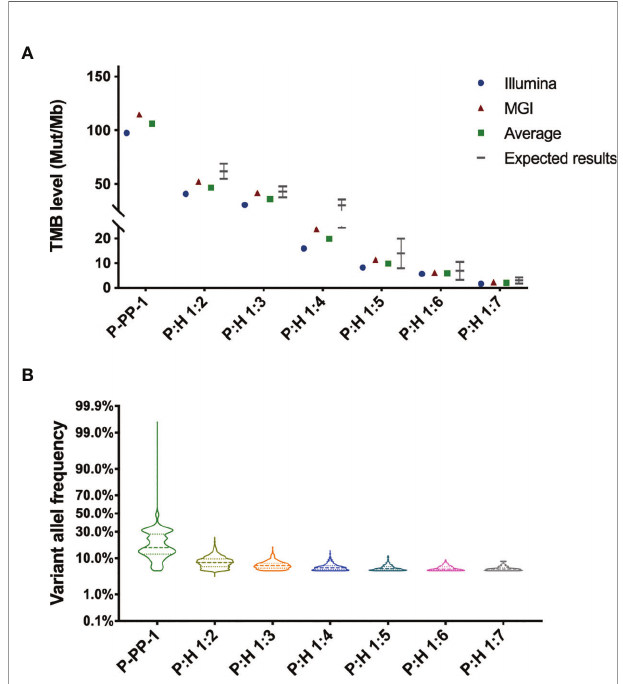
FIGURE 5 | Sample validation of the novel FFPE reference materials by double-platform whole exome sequencing. (A) Sample validation by double- platform whole exome sequencing for the novel FFPE reference materials. Data showed in the form of mut/Mb. The mean values of all samples were consistent with their individual target values, spanning a clinically relevant range (2.0 – 106.1 mut/Mb). (B) Distribution of the variant allele frequency of nonsynonymous mutations in the novel FFPE reference materials.